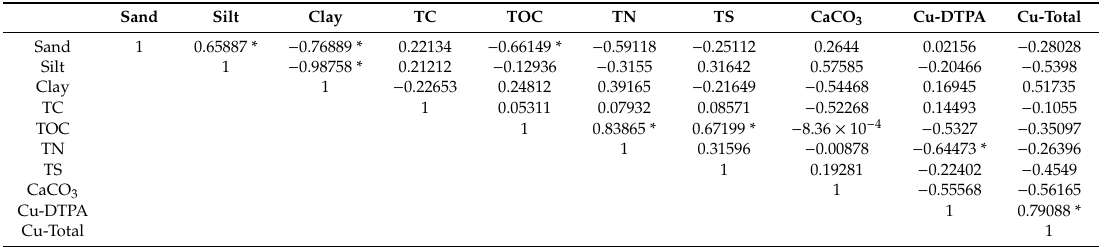
Table A2. Correlation matrix (Pearson) of the Aetoliko lagoon sediments